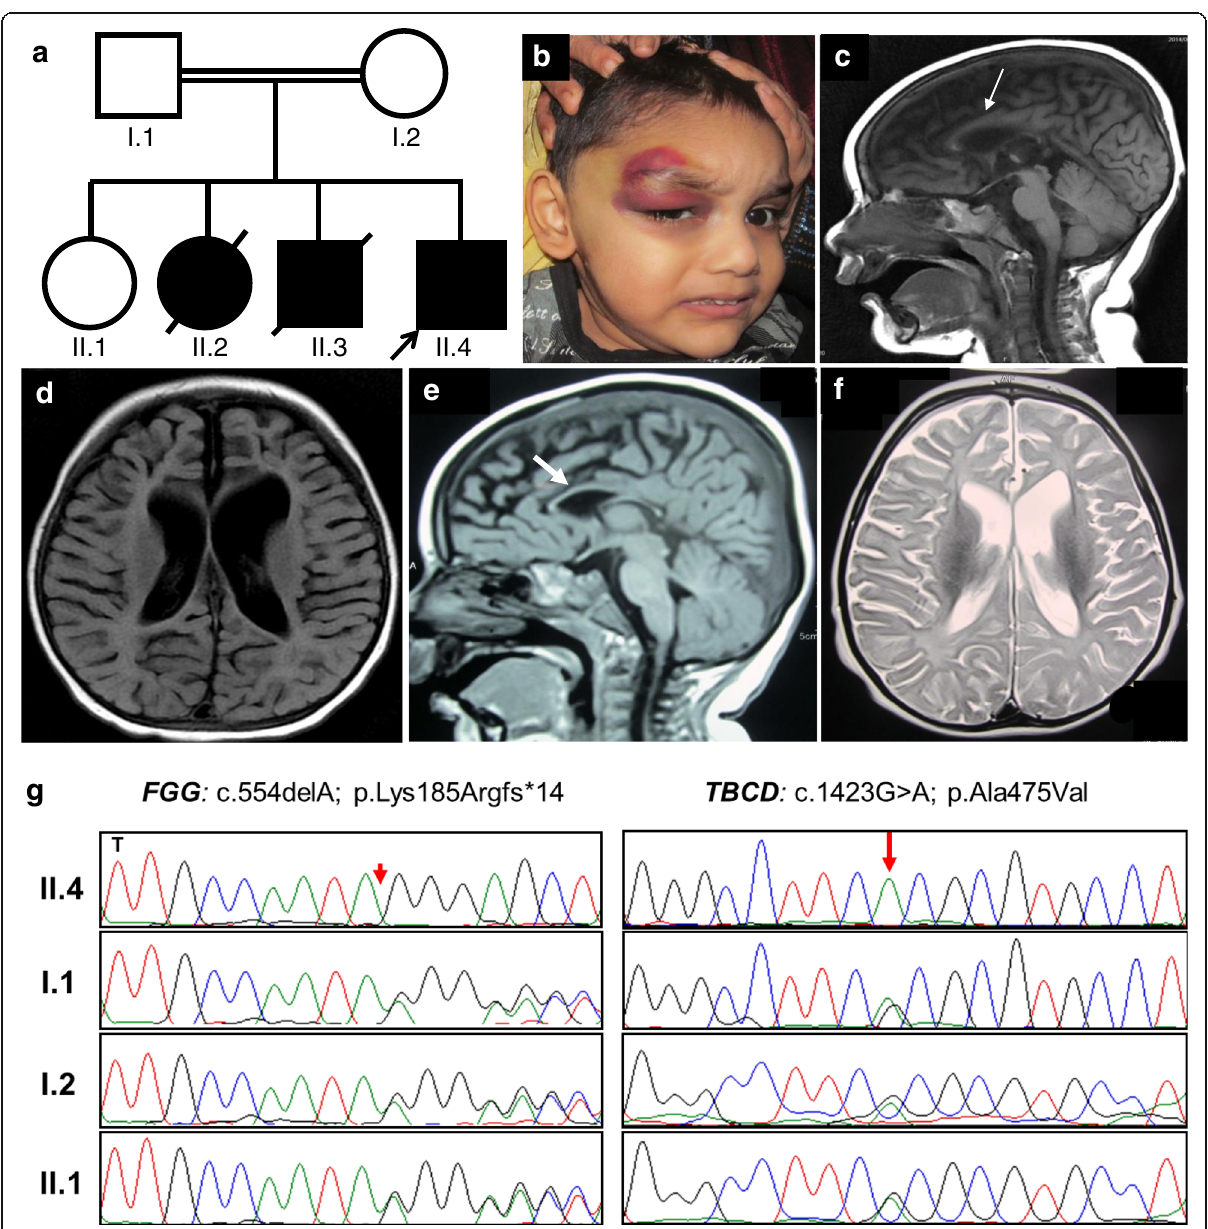
Fig. 1 Clinical features and sequencing of the variants. a Pedigree shows three affected siblings, the youngest of whom is the proband (arrow) ( b ) Photograph of the proband showing hematoma at the right upper eyelid, microcephaly and deep set eyes. c-d MRI brain of the proband (II.4) at 1.5 years of age. T1 sagittal ( c ) and T2 flair coronal ( d ) show significant cerebral cortical atrophy with predominant white matter volume loss along with thinning of the corpus callosum (white arrow). e-f Brain MRI of the elder sibling (II.3) at 1 year of age, T1 sagittal ( e ) and T2 axial ( f ). The findings are similar to those of the proband with marked cortical atrophy with white matter volume loss and thinning of corpus callosum (white arrow). g Sanger sequencing showing the carrier status of both the variants ( FGG : c.554delA and TBCD : c.1423G > A) in the parents (I.1 and I.2) and unaffected sibling (II.1). The proband (II.4) is homozygous for both the variants. DNA samples from II.2 and II.3 were